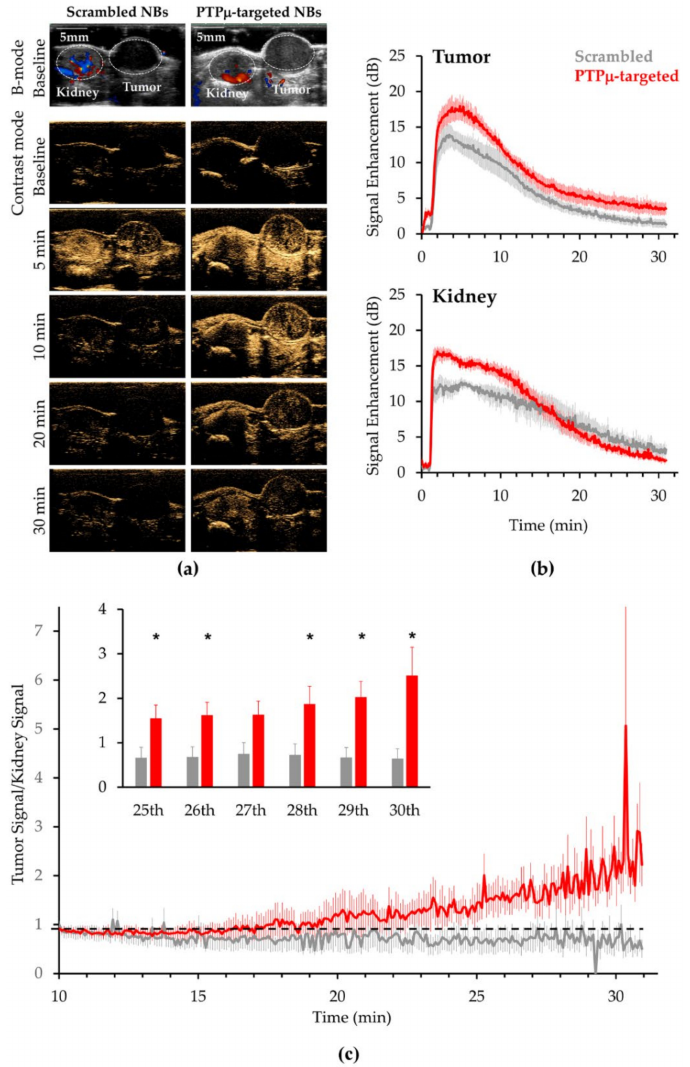
Figure 3. Ultrasound imaging of a representative tumor-bearing mouse treated with Scrambled and PTP µ -targeted NBs and time intensity curves from the tumor-bearing mouse cohort after adminis- tering Scrambled and PTP µ -targeted NBs. ( a ) In vivo US signal produced by the two NB types at various times. Baseline images in B-mode used for positioning and contrast mode images are shown for a representative mouse administered Scrambled NB (left) compared to PTP µ -targeted NB (right) along with contrast mode images at indicated times following the start of the scan. NBs were injected at a rate of 0.26 mL/min after acquiring a 1 min baseline. ( b ) The contrast harmonic signal measured over time in tumor (top plots) and kidney (bottom plots) in response to Scrambled-NB (gray) and PTP µ -targeted NBs (red). N = 6 for mice injected with Scrambled-NBs, N = 7 for mice injected with PTP µ -targeted NBs. Plots show mean signal intensity ± standard error. ( c ) Tumor signal normalized to kidney signal for the mice shown in panel ( b ) at later time points. PTP µ -targeted NBs showed relatively slower clearance from the tumor towards the end of the scan time compared to Scrambled NBs. Plots show mean normalized value ± standard error. Inset shows mean normalized values during the indicated one-minute intervals for the two NBs types (* p < 0.05 as indicated for 25th–26th and 28th–30th minutes, p = 0.05 for the 27th minute interval). During the 30th minute, the normalized PTP µ -targeted NB value was 3.9-fold higher than that of the untargeted